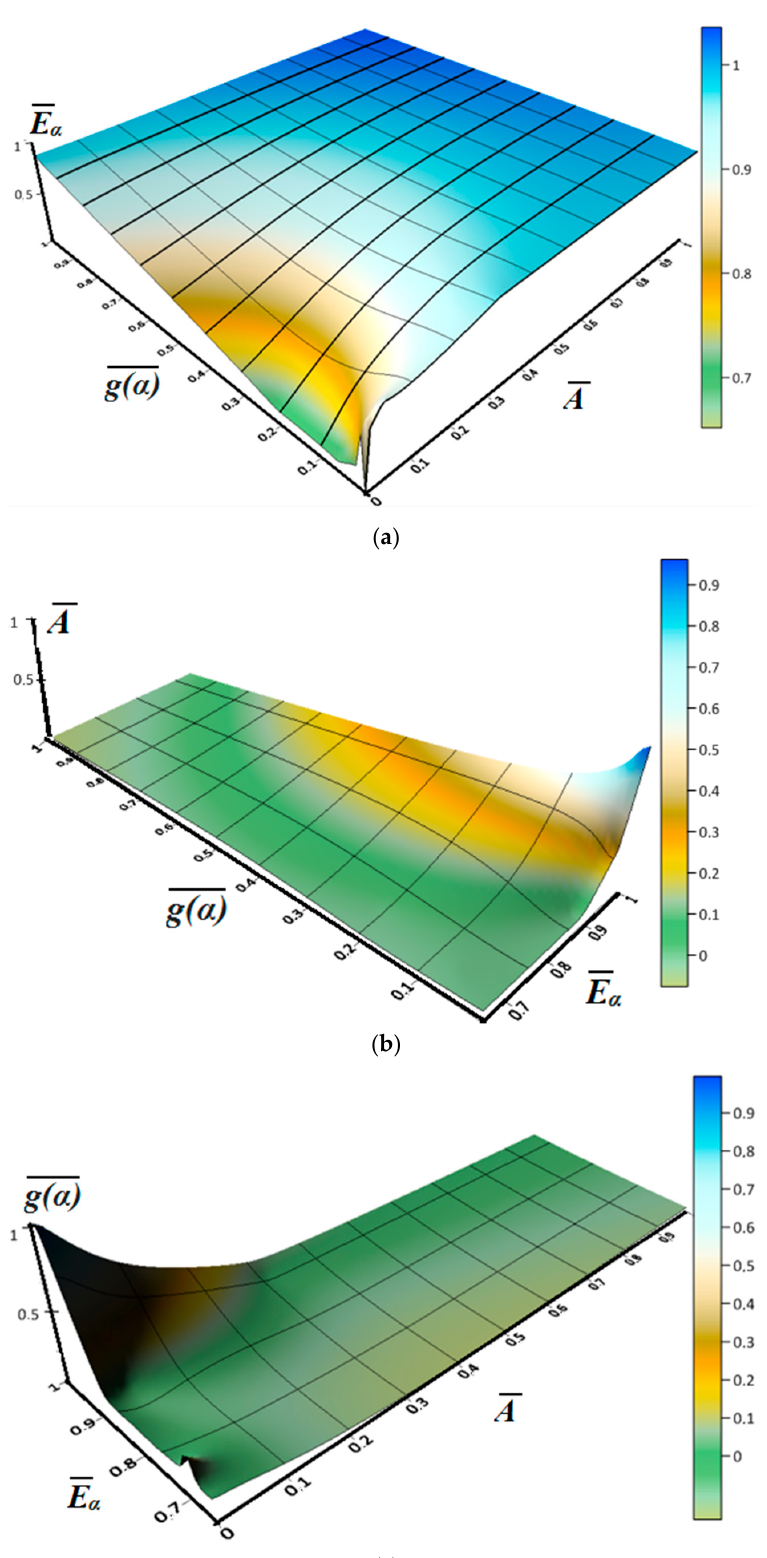
Figure 6. Surface plots of parameters, viz.: ( a ) activation energy; ( b ) pre-exponential factor; ( c ) alge- braic function g ( α